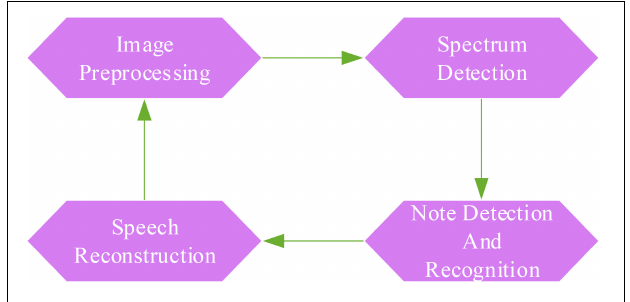
FIGURE 4 | Workflow of OMR system.